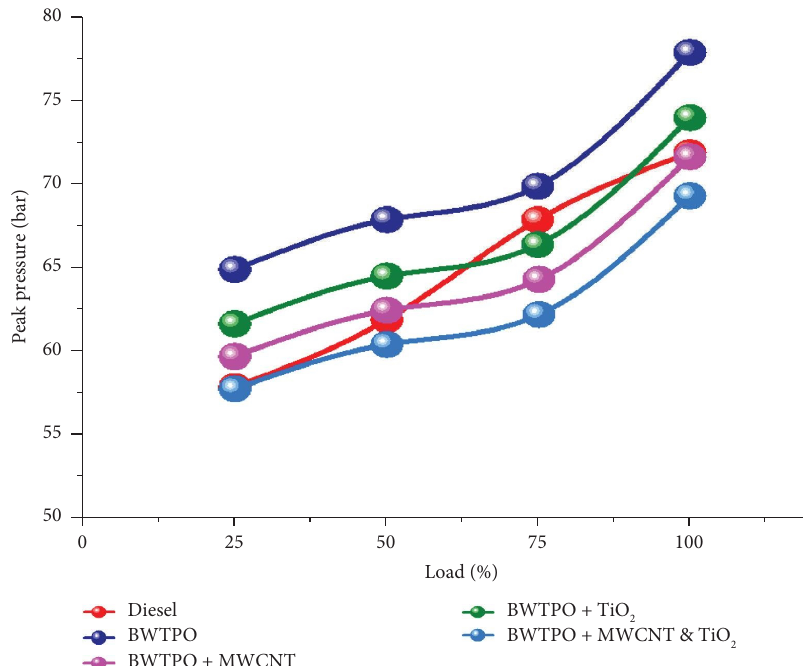
Figure 11: Relationship between the peak pressure (bar) and load variations